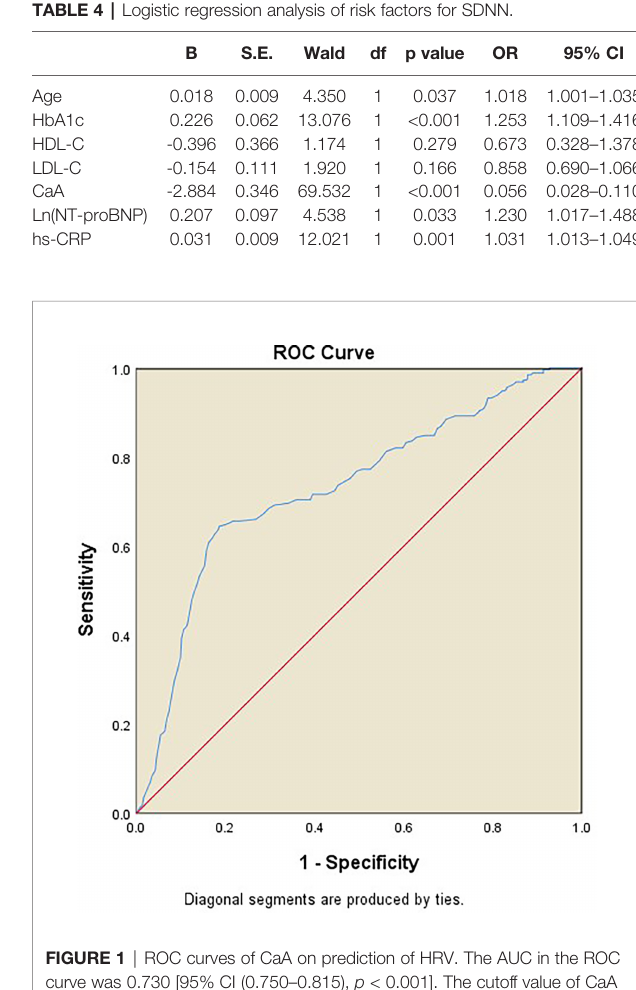
TABLE 4 | Logistic regression analysis of risk factors for